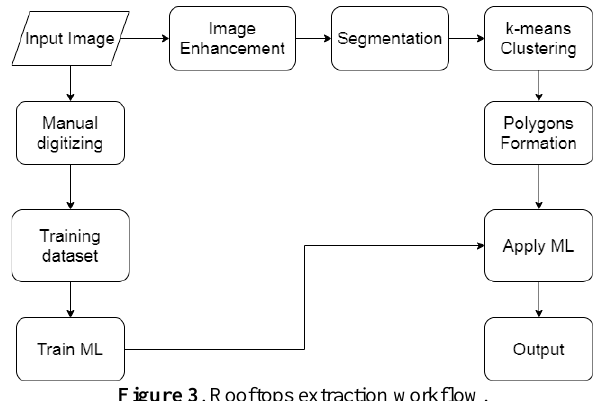
Figure 3 . Rooftops extraction workflow.